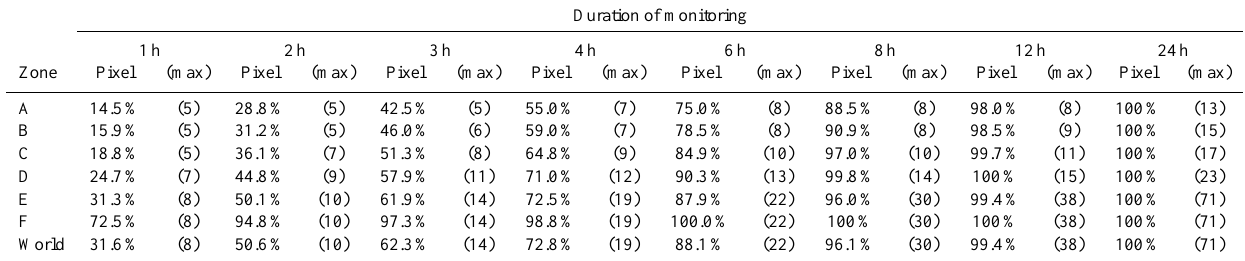
Fig. 3. SACS SO 2 vertical column density images from IASI and AIRS for 13 and 14 June 2011 at the beginning of the eruption of Nabro. Note that IASI and AIRS observations are plotted using circles with mean diameters of respectively 12 and 15km. Table 2. Geographical coverage of SACS monitoring for October